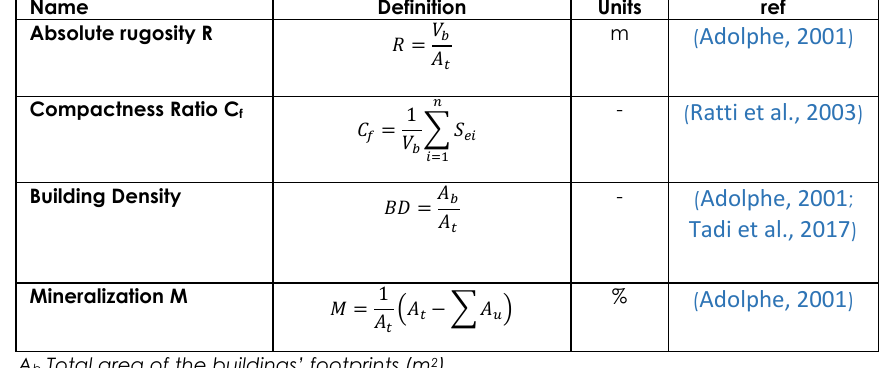
Table 1. Parameters and their expression used for the environmental assessment.